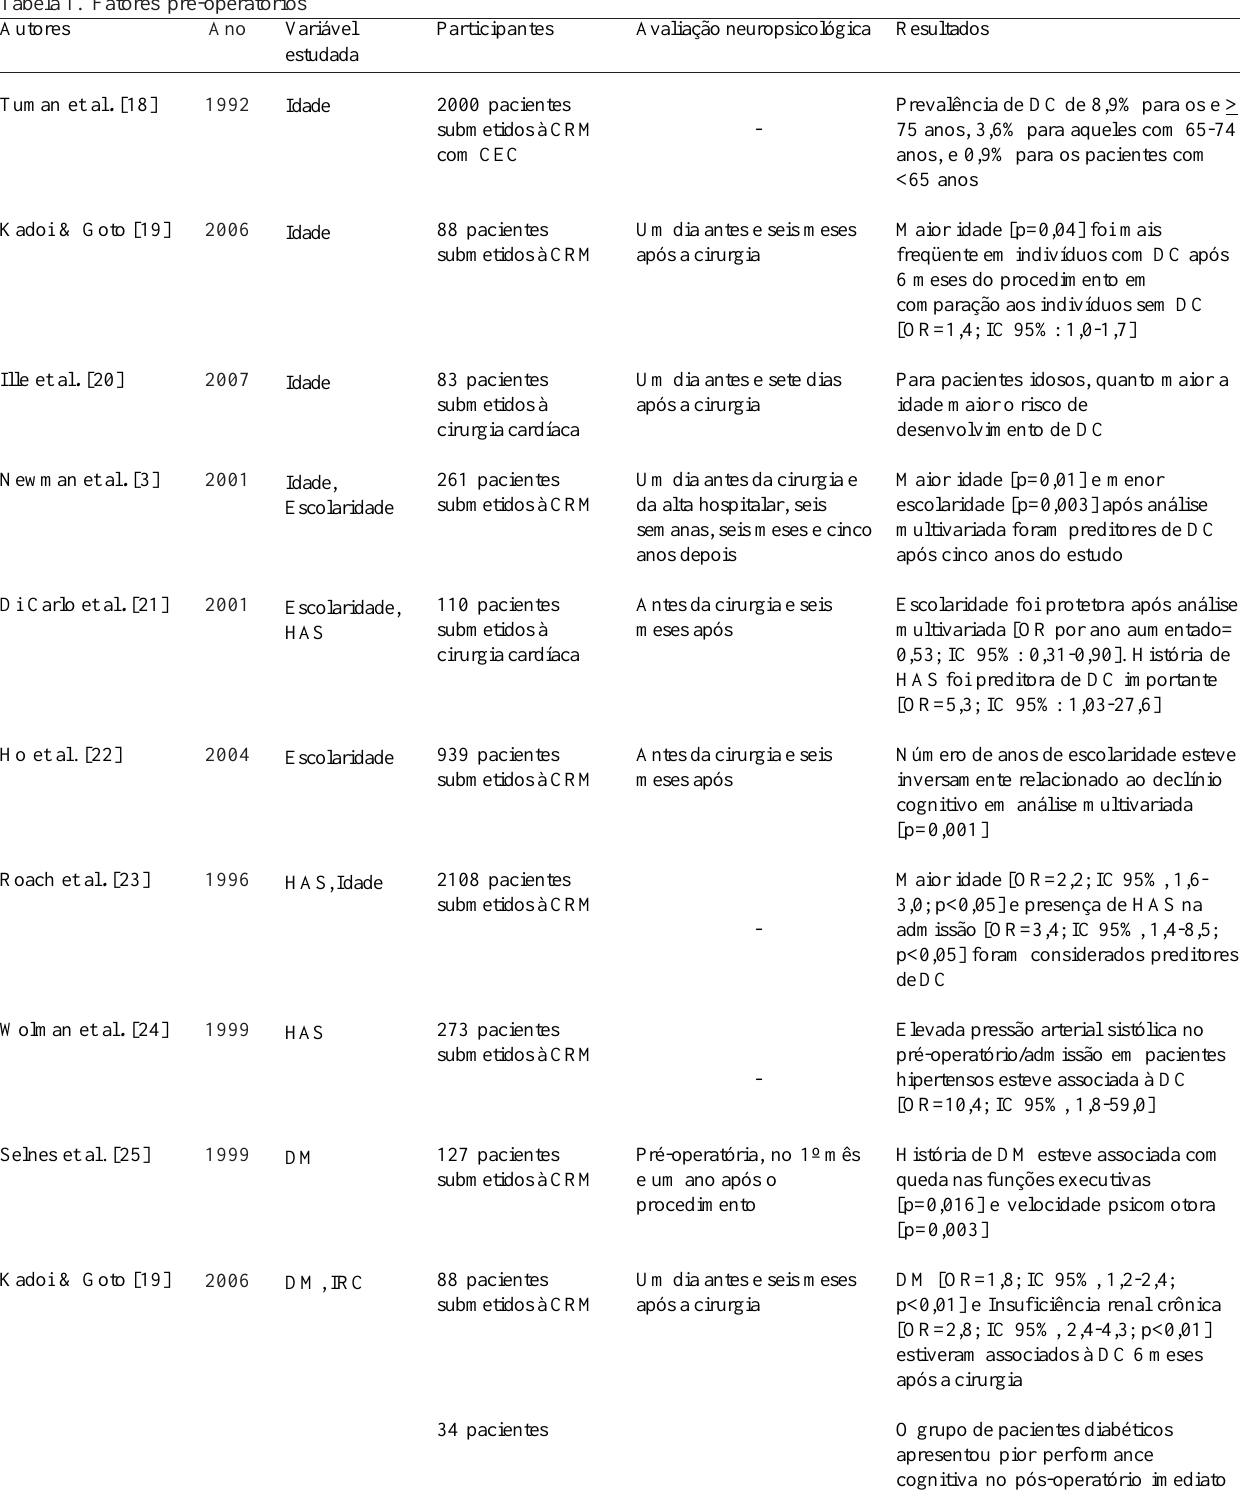
Tabela 1. Fatores pré-operatórios